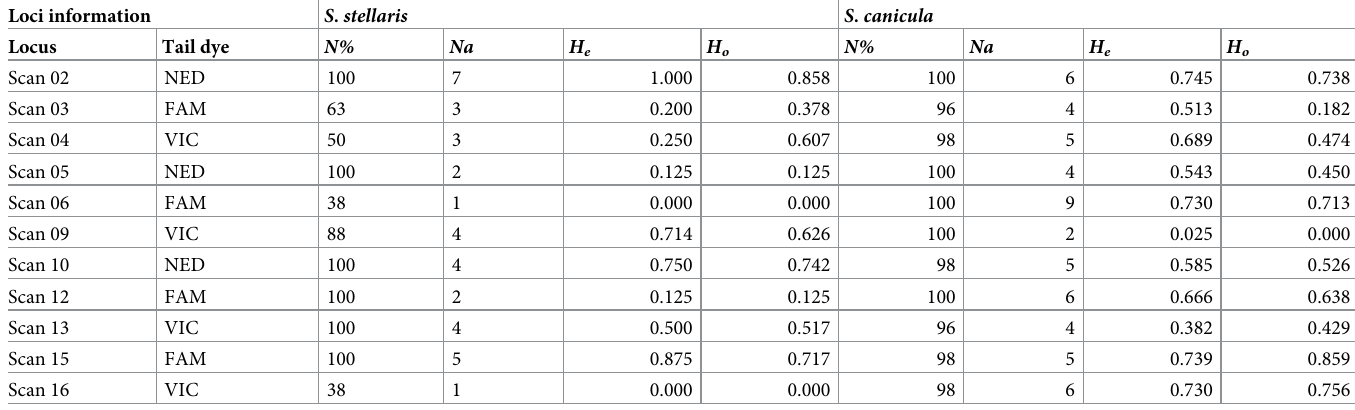
Table 2. Microsatellite information gathered from each locus for the entire population studied (including the twins) for S . stellaris and S . canicula . N% = Percentage of individuals scored, Na = numbers of alleles, H e = expected heterozygosity, H O = observed heterozygosity. Loci information S . stellaris S . canicula